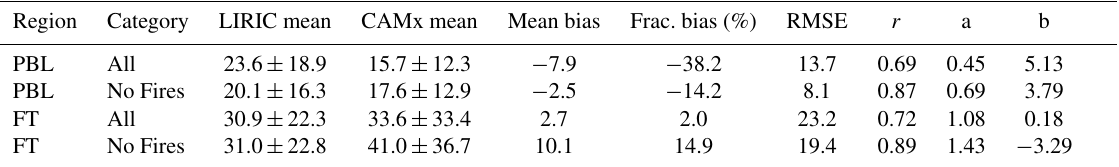
Figure 6. Scatterplots of the PM 2 . 5 integrated mass in the boundary layer (left) and in the free troposphere (right) for LIRIC and CAMx in the period 2013–2015. The biomass burning cases are marked with red, while the dust cases are marked with orange. The “nf” label corresponds to metrics of the category “no fires”. The least square fit line corresponding to the screened cases (blue and orange) is also included. Table 4. PM 2 . 5 integrated mass metrics. Two atmospheric regions are provided. The region below the boundary layer is symbolized as PBL, while the region above it, in the free troposphere, is defined as FT. The category “All” corresponds to the total of the cases (22 in total), while the category “No Fires” refers to the cases that are not classified as wildfires (16 out of 22). The mean, standard deviation, mean bias and root mean square error values are in mgm − 2 units. Pearson’s correlation coefficient ( r ) and the least square fit slope (a) and intercept (b) values are also